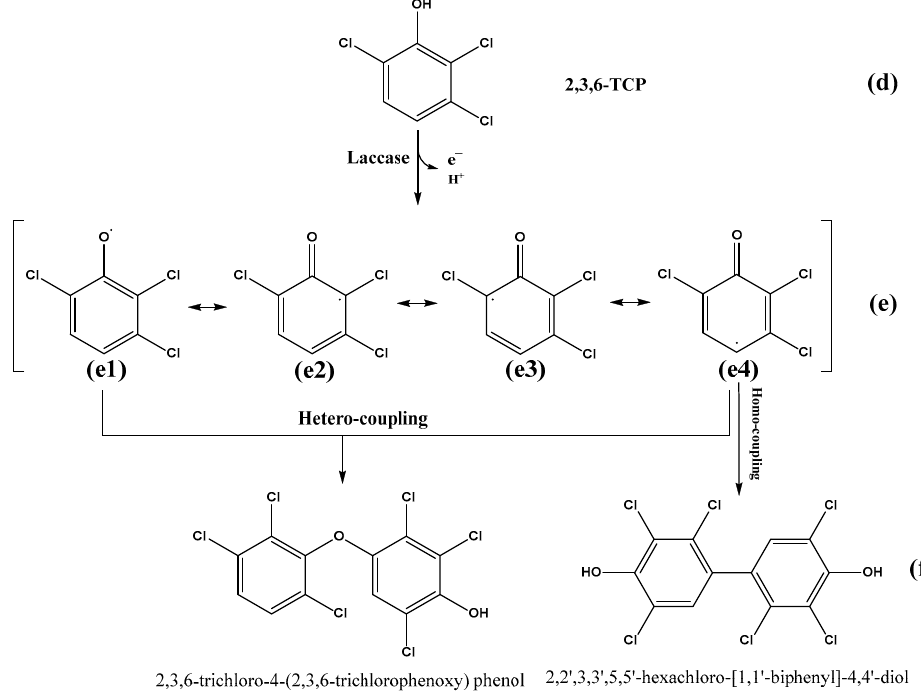
Figure 16. Speculation of the degradation pathway of 2,3,6-TCP catalyzed by LAC-4 laccase. The putative degradation pathway of 2,3,6-TCP catalyzed by LAC-4 laccase.